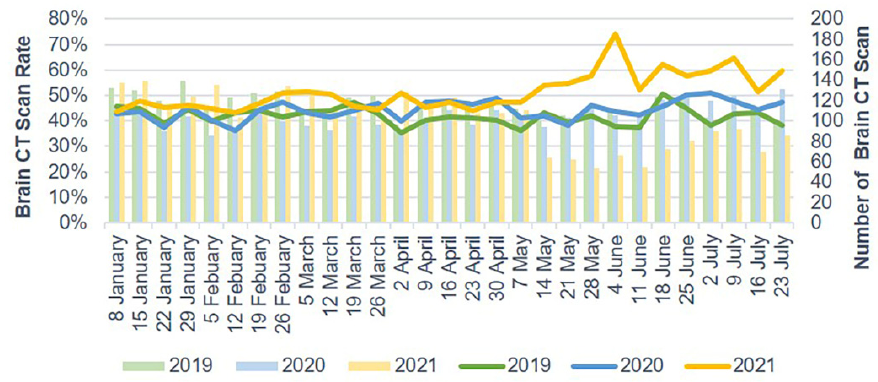
Figure 6. Brain CT scan rate for TBI in the ED from January to July 2019, 2020, and 2021. CT scan, computerized tomography scan; ED, emergency department; TBI, traumatic brain injury.